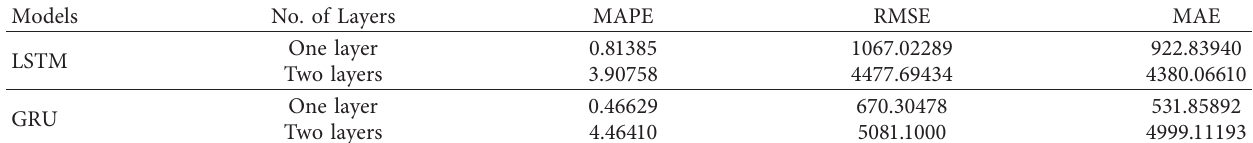
Table 3: The result of DL for confirmed cases in Egypt.